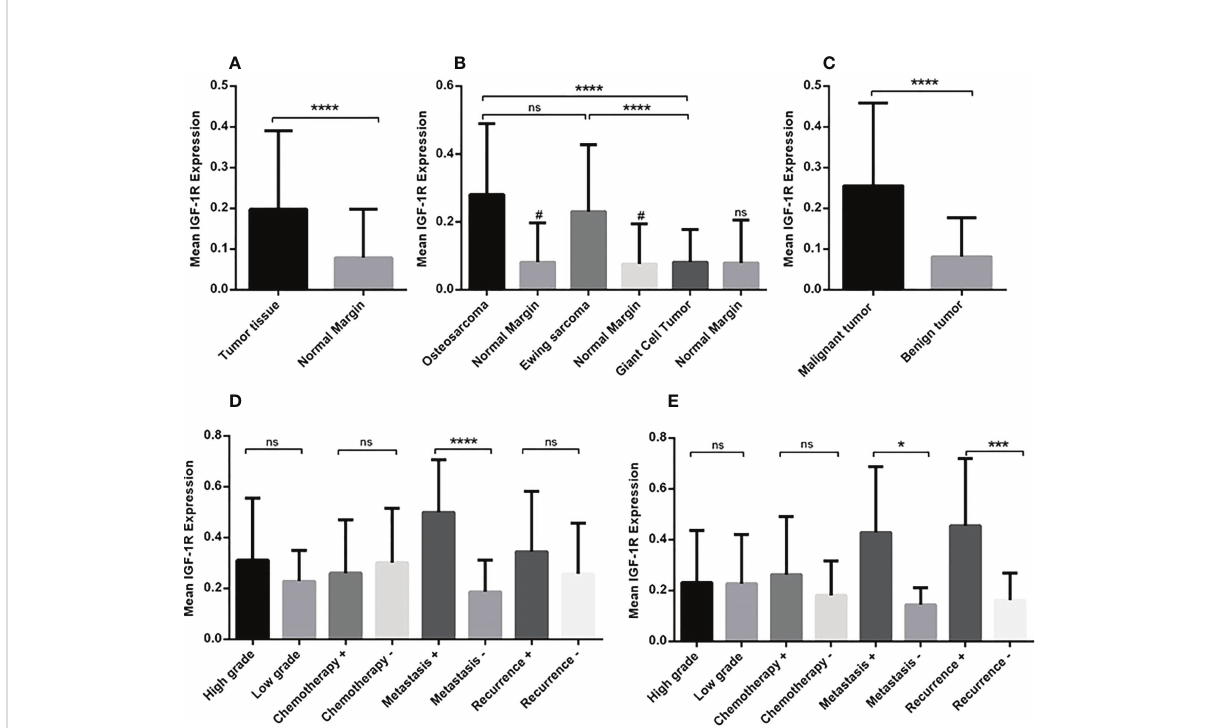
FIGURE 1 The gene expression level of IGF-1R in osteosarcoma, Ewing sarcoma and GCT. The mean mRNA expression level of IGF-1R increased in bone tumor (N=90) tissues compared to the adjacent noncancerous tissues (N=90) (A) . The elevated level of expression was detected in osteosarcoma (N=30), Ewing sarcoma (N=30) and GCT (N=30)compared to the margin tissues (30 tumor margin tissues that were obtained and compared for each tumor group separately) also osteosarcoma (N=30) compared to the GCT (N=30) (B) . The difference in the IGF-1R expression in malignant (N=60) and benign tumors (N=30) is shown (C) . The comparison of IGF-1R expression level in tumor subtypes including tumor grade, chemotherapy-received status, metastasis, and recurrence is shown separately for osteosarcoma (D) and Ewing sarcoma (E) . The number of examined samples in each tumor subtype is shown in Supplementary Table 1. The statistical differences between groups are shown as asterisks (*P <0.05, ***P <0.001, ****P<0.0001), (ns) indicates unspeci fi c, (#) indicates P<0.0001 for comparing osteosarcoma and Ewing sarcoma with adjacent noncancerous